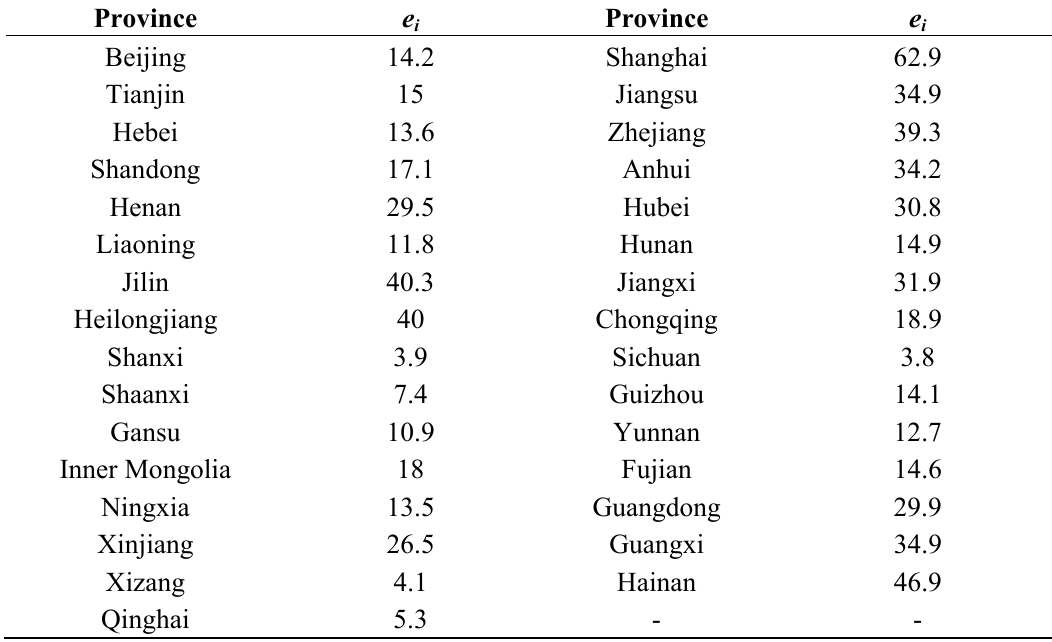
) in various Chinese provinces i